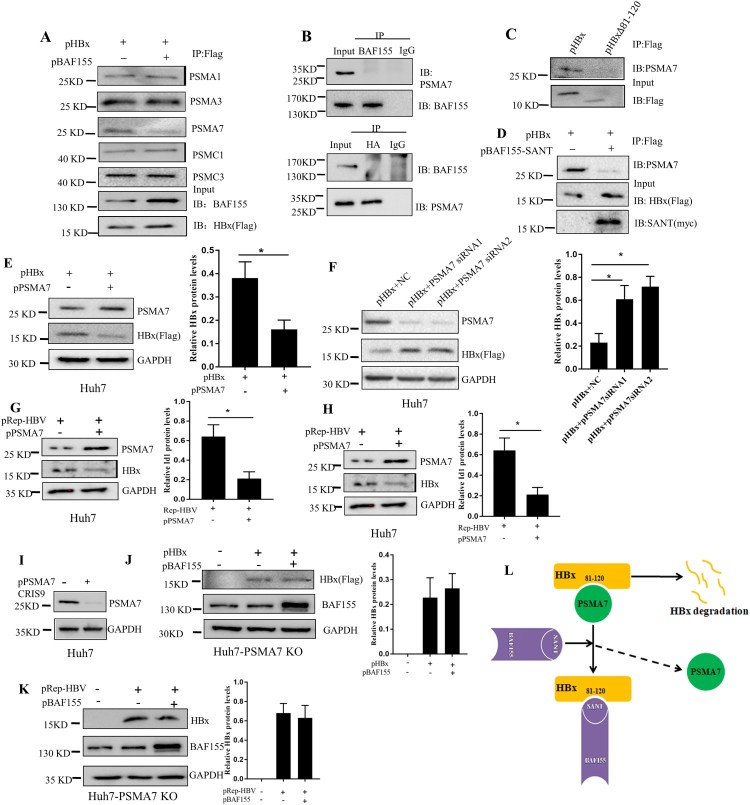
BAF155 stabilizes HBx through inhibition of proteasome-mediated protein degradation. (A) Coimmunoprecipitation of HBx and proteasome in the presence of proteasome inhibitor. Huh7 cells were transfected with pHBx in combination with pBAF155. 24 h after transfection, cells were treated with 20 μM MG132 for 6 h. Total cell extracts were first subjected to immunoprecipitation using anti-Flag antibody and then the immune complex was assayed by western blotting with respective antibodies. (B) Coimmunoprecipitation analysis of interaction between the BAF155 and PSMA7. (C) Coimmunoprecipitation analysis of interaction between the HBx mutant lacking aa81-120 and PSMA7. (D) Coimmunoprecipitation analysis of interaction between BAF155 SANT domain and PSMA7 in the presence of HBx. (E) Overexpression of PSMA7 decreased HBx protein levels in pHBx-transfected Huh7 cells. (F) Knockdown of endogenous PSMA7 increased HBx protein levels in the Huh7 cells transfected with pHBx. (G) Overexpression of PSMA7 decreased HBx protein levels in the Huh7 cells transfected with pRep-HBV. (H) Knockdown of endogenous PSMA7 increased HBx protein levels in the Huh7 cells transfected with pRep-HBV. (I) Knockout of PSMA7 in Huh7 cells by CRISPR/Cas9 system as examined by western blot analysis. (J and K) The protein levels of HBx in the PSMA7-knockout Huh7 (Huh7-PSMA7 KO) cells transfected with pBAF155 in combination with pHBx (J) or pRep-HBV (K). (L) Schematic models for the mechanism by which BAF155 functions to compete with PSMA7 for binding to HBx thus disrupting PSMA7 native association with HBx for HBx degradation. Values are mean ± SD, n = 3. *p < 0.05.